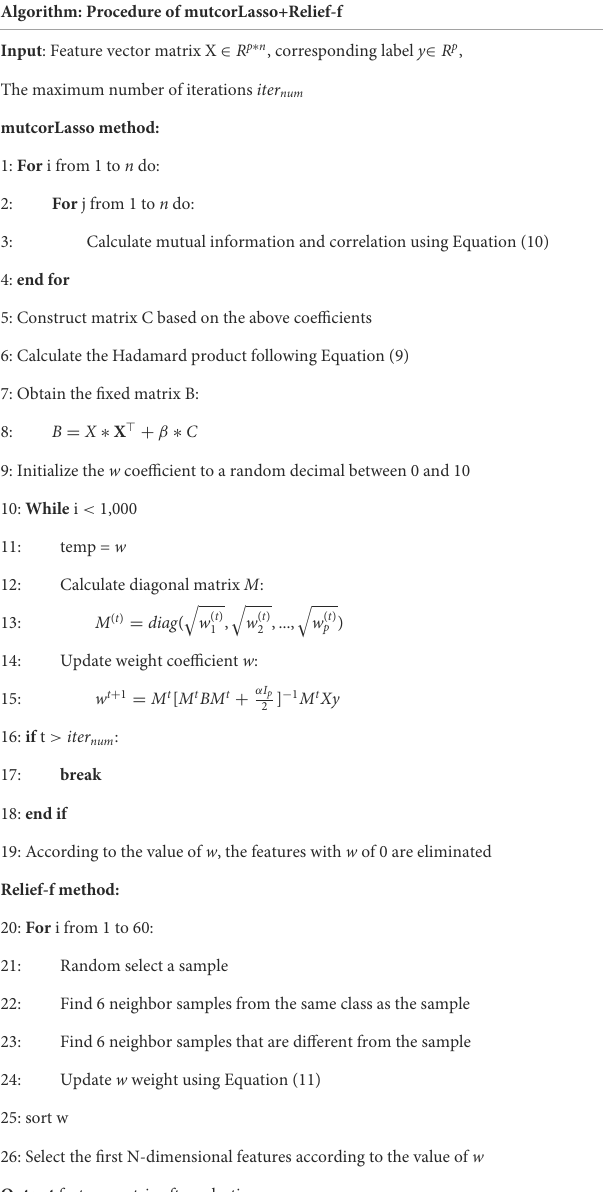
verify the results of RF classifier. Taken K3b dataset as example, Figure 2 represented the learning rates α and β of mutcorLasso algorithm, respectively. Although the parameters range between 0.1 and 1, which is relatively small, it affects the